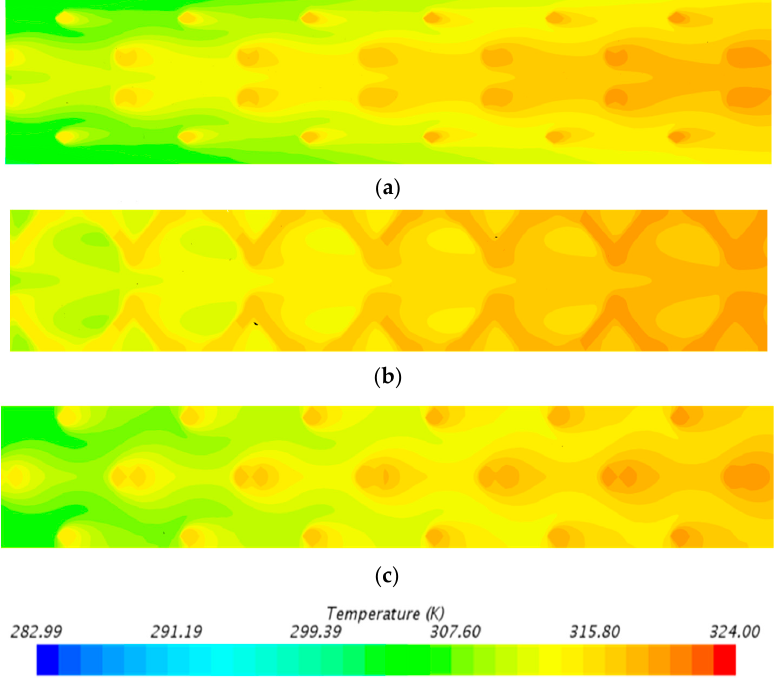
Figure 12. Temperature scale in three planes: ( a ) Oblique cross section, ( b ) center section, ( c ) x = − 1 mm cross section.